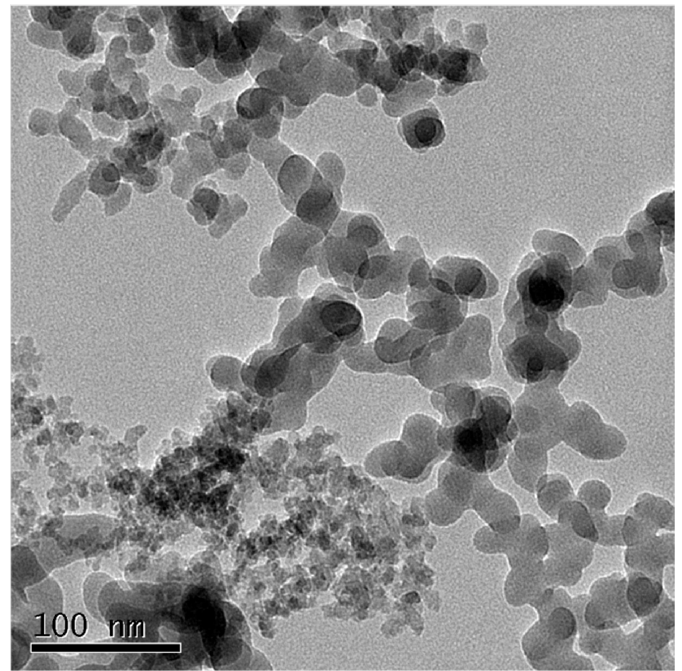
Figure 3. Scanning electron microscope (SEM) image of NS particles.